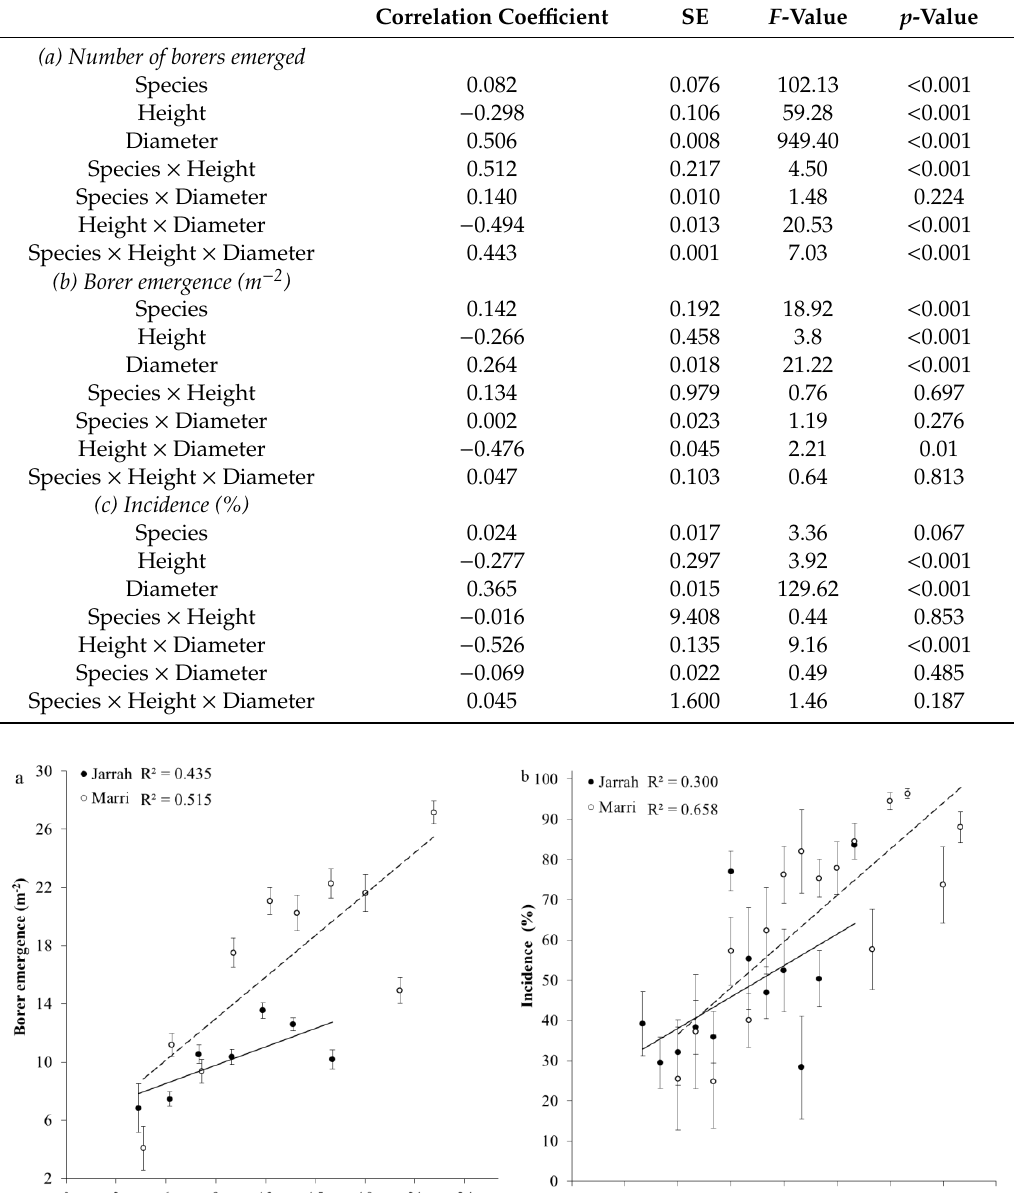
Table 3. Tree factors influencing the distribution of borer emergence, borer emergence (m − 2 ) and incidence of larval galleries (%) of the Australian eucalyptus longhorned borer Phoracantha semipunctata for jarrah ( Eucalyptus marginata ) and marri ( Corymbia calophylla ) trees in the Northern Jarrah Forest (NJF), Southwestern Australia. Predictions of the association (using Generalised Linear Mixed Models) between ( a ) number of borers emerged with height; ( b ) density of borers emerged with height and ( c ) incidence with height. The final analyses included all the variables and interactions with species and tree factors listed below (residual deviance; model 1 = 5.46, model 2 = 6.25, n = 861 degrees of freedom, residual deviance model 3 = 2.59, n = 454 degrees of freedom).